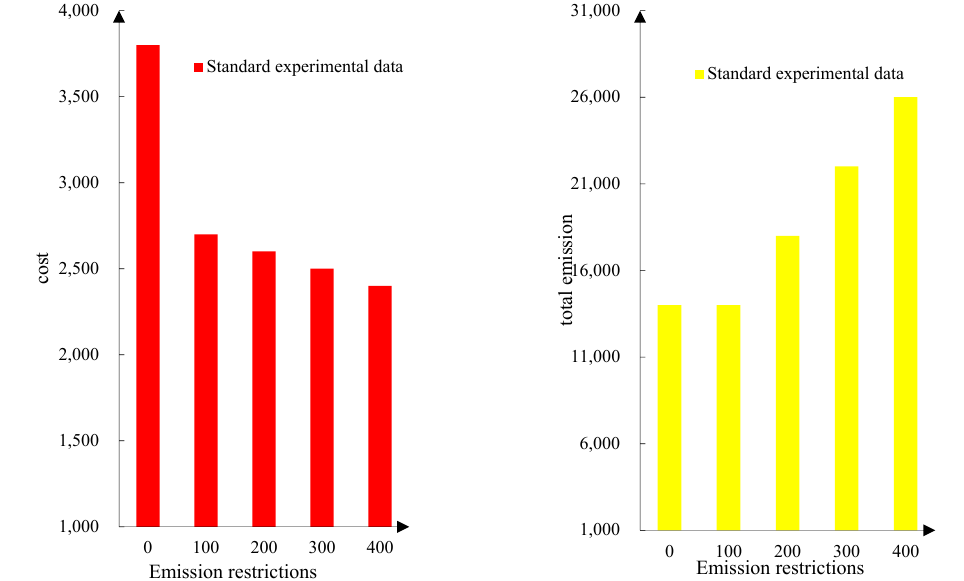
Figure 7. Pathway emission relationship under standard experimental data.